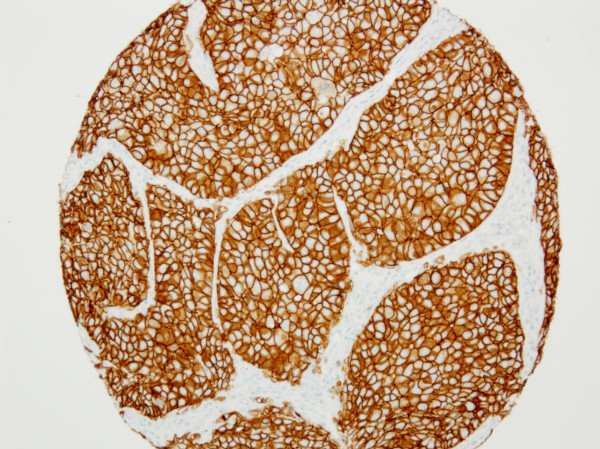
TMA core displaying strong membranous HER2 staining (3+, 4B5 antibody). HER2, human epidermal growth factor receptor 2; TMA, tissue micro-array.